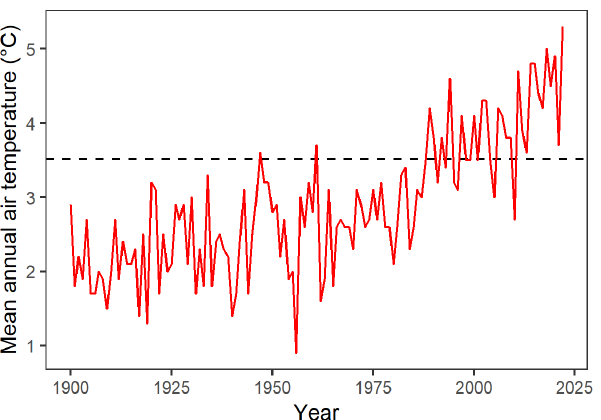
Figure 2. Mean annual air temperature at 2 m height (1900–2022) at the MeteoSwiss weather station in Davos at 1594 m a.s.l. The dashed horizontal line represents the corresponding value for the climate norm period 1981–2010 (source: MeteoSwiss).